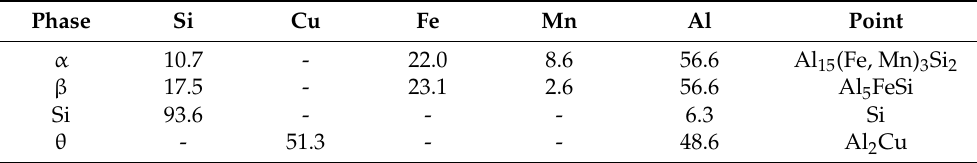
Table 2. Chemical compositions of the main intermetallic phases in the as-cast Al6Si2Cu alloy (wt.%). Phase